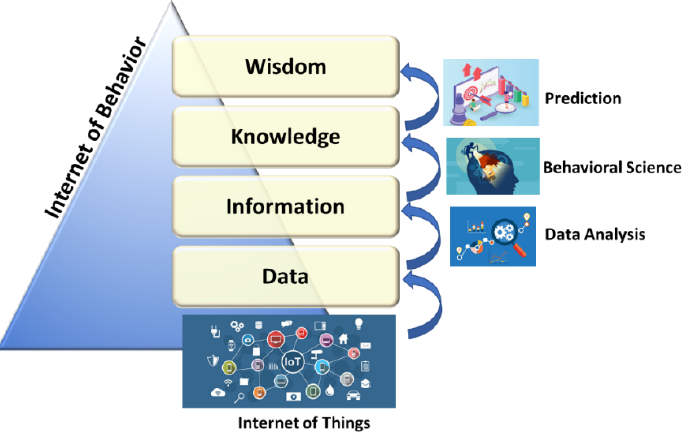
Figure 1. Scheme of internet of behavior from data